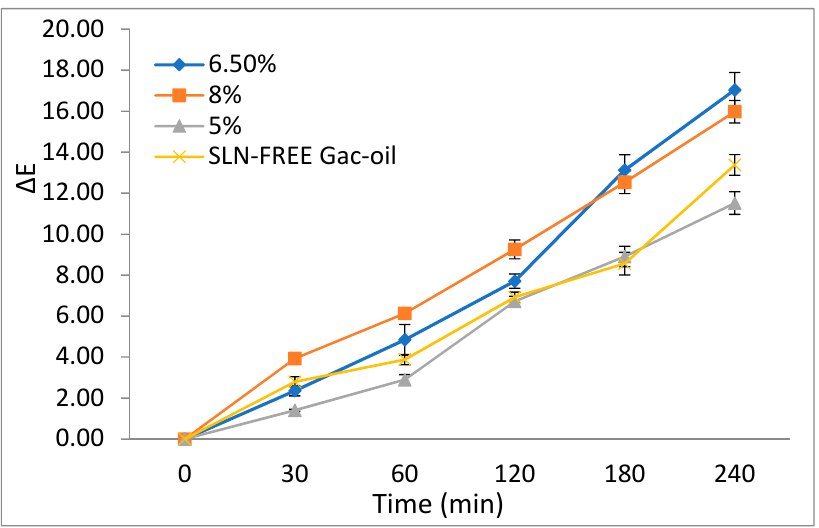
Figure 11. Effects of UV light on ∆ E values of the samples including 8% gac oil-loaded SLNs, 6.5% gac oil-loaded SLNs, 5% gac oil-loaded SLNs and SLN-FREE gac oil.